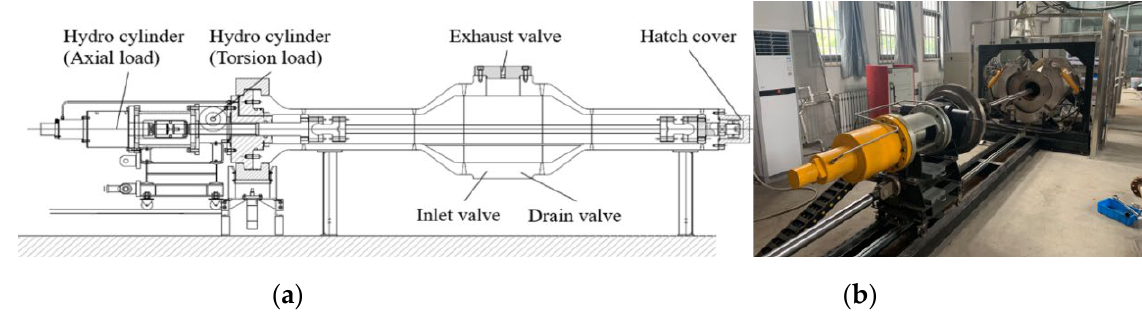
Figure 5. ( a ) Longitudinal sectional view in the middle plane; ( b ) experiment setup.